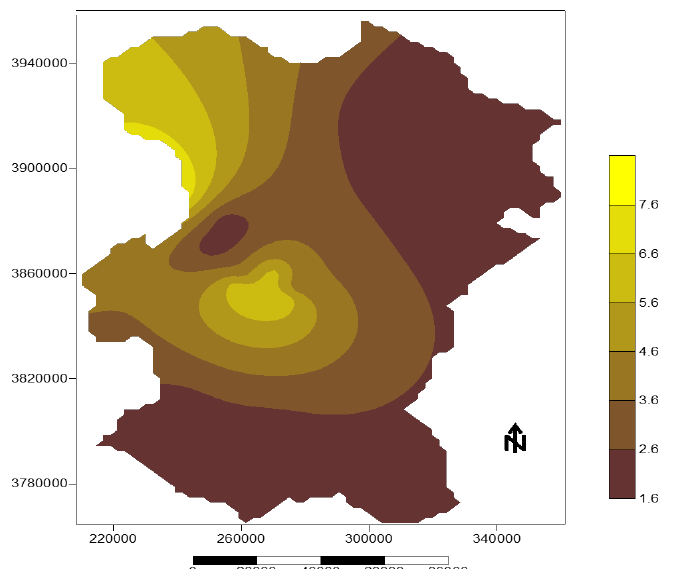
Fig. 4. Zoning of sub-basin slope in Gamasyab and Gharechay